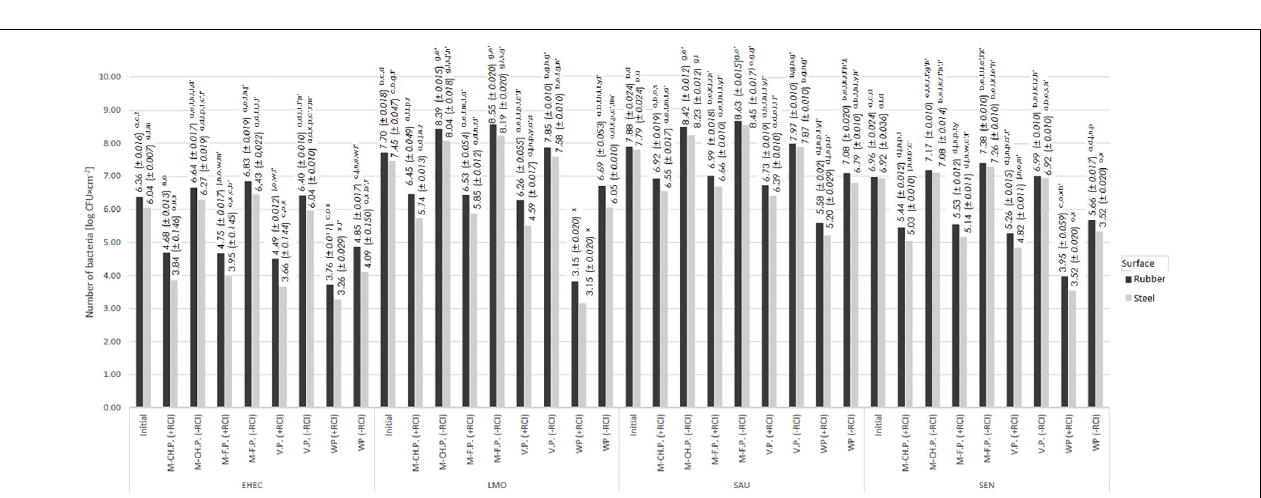
FIGURE 4 | Changes in the number of bacteria under the influence of RCI depending on the distance from device [a, b, c – values marked with different letters are significantly different ( P < 0.05); EHEC – E. coli O157:H7; LMO – L. monocytogenes ; SAU – S. aureus ; SEN – S . Enteritidis].